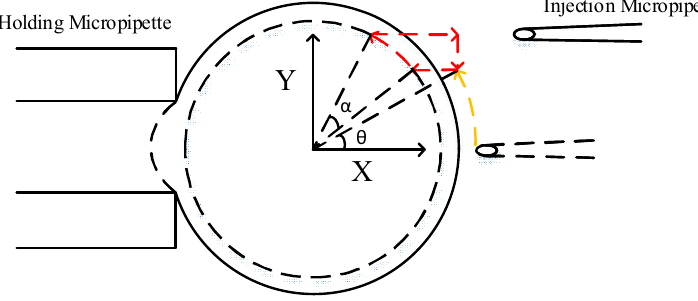
Figure 6. Rotation strategy of the second stage (vertical view).